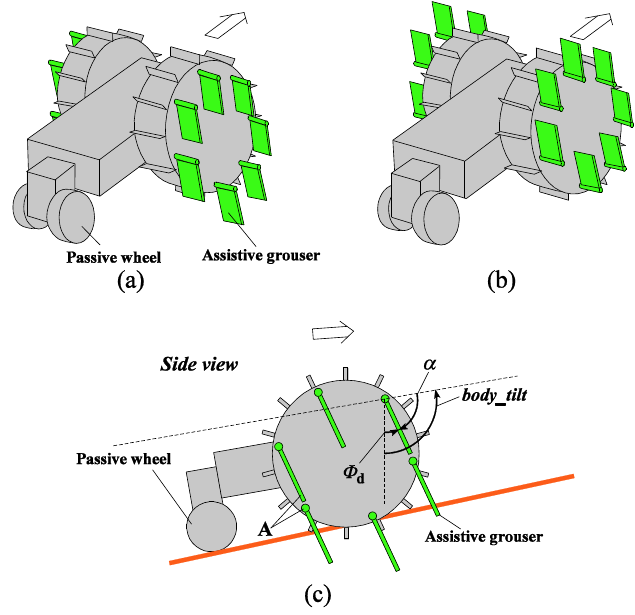
Figure 3. Diagram of a wheeled rover with assistive grouser mechanism: ( a ) Assistive grouser angle pointing downwards to be in contact with the terrain; ( b ) Assistive grouser angle rotated upwards away from ground surface; ( c ) Relationship between body_tilt , α and Φ d .